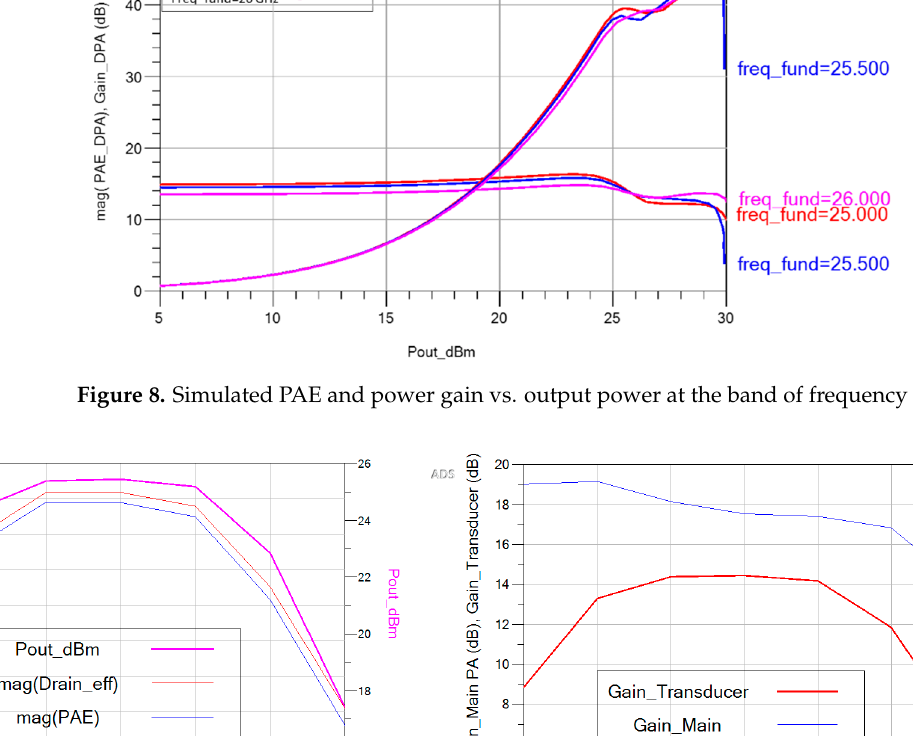
( b ) Figure 7. Simulated ( a ) magnitude of PAE and drain efficiency at the center frequency, ( b ) power gain of the main PA in comparison with the DPA gain in terms P (cid:2925)(cid:2931)(cid:2930) . Once the main PA is saturated by the 3 dB compression, the peaking PA provides more power, thus assisting the DPA’s large signal gain operation. The DPA is likely to be linear as long as the gain characteristic in the modulation region remains constant. Figure 8 illustrates the similar efficiency and power gain performance of the DPA for frequencies 25, 25.5 and 26 GHz. In the target bandwidth, the variations in the power gain, PAE and drain efficiency at the input power of 10 dBm in Figure 9a,b indicate that the PAE varies between 32% and 40%, reaching a peak at 24.4 GHz, while a large signal gain